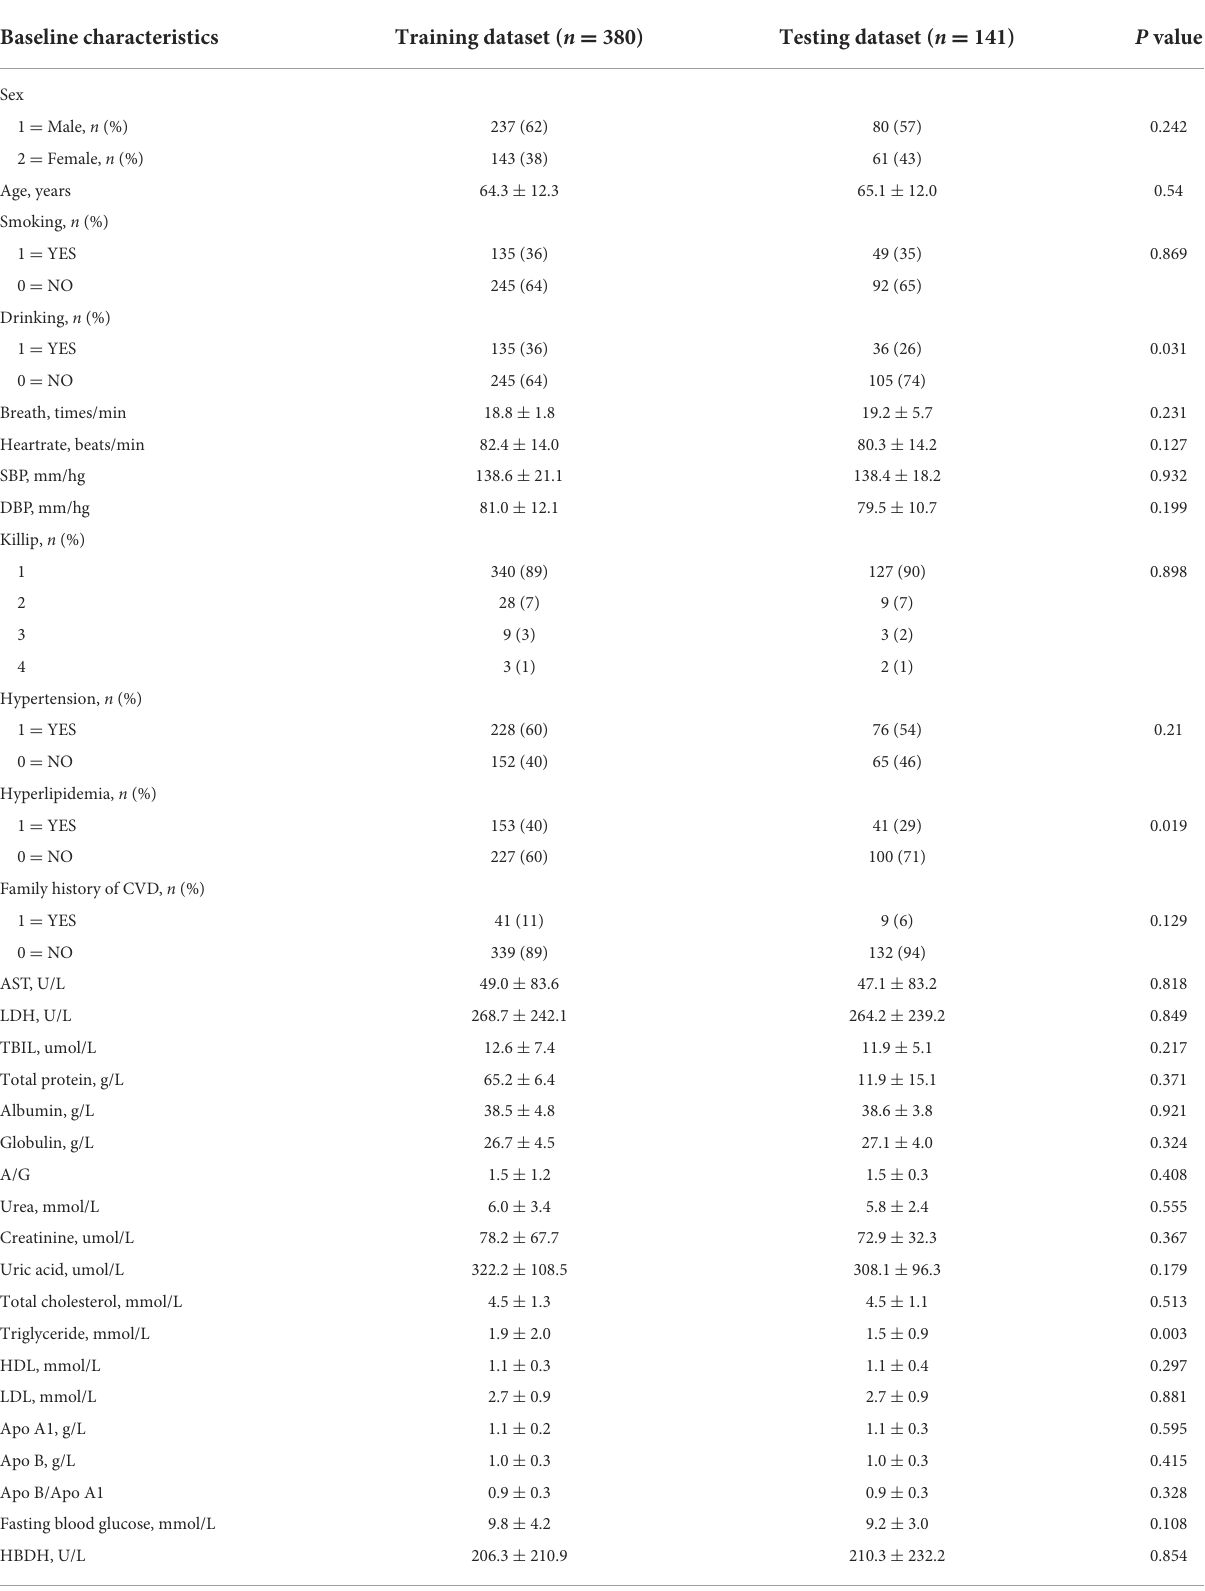
TABLE 1 Patients